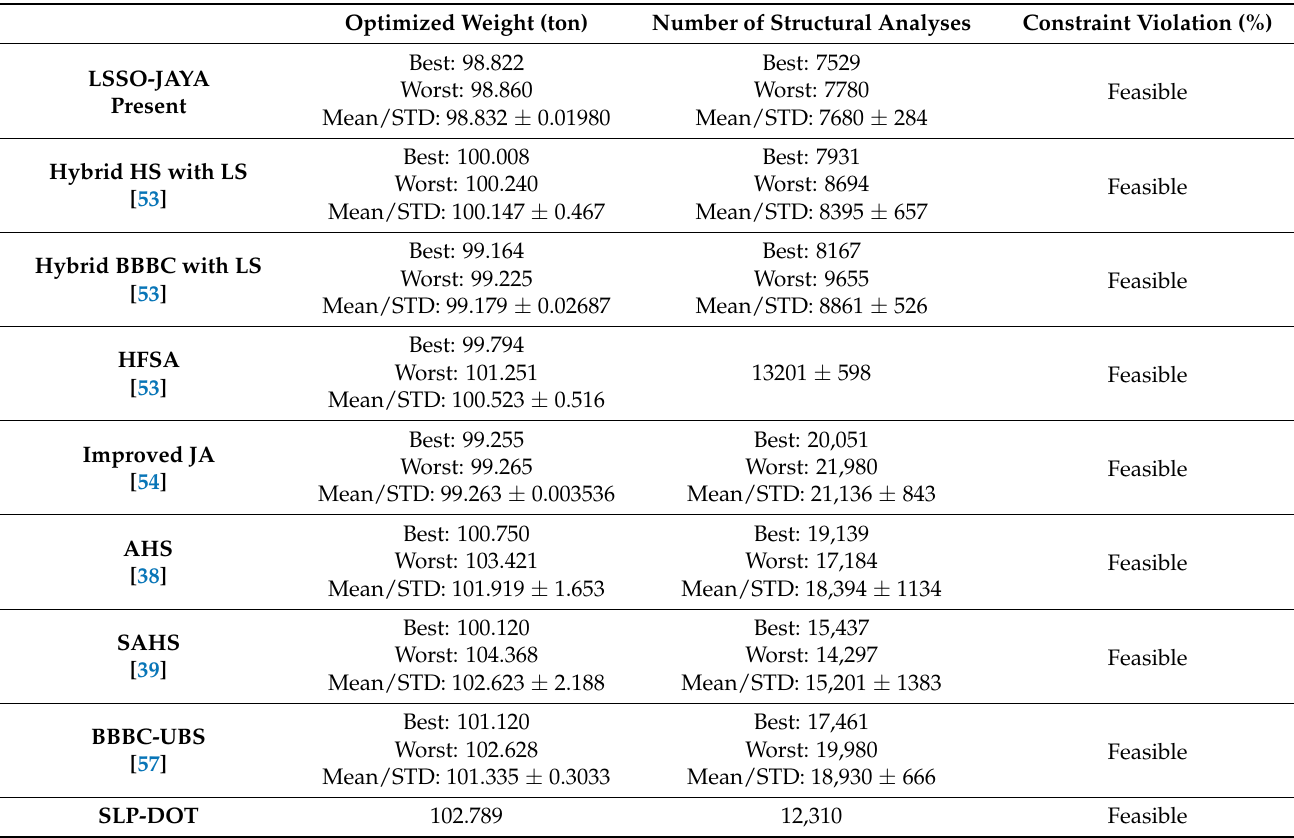
Table 4. Optimization results obtained for the 1938-bar tower design example. Optimized Weight (ton) Number of Structural Analyses Constraint Violation